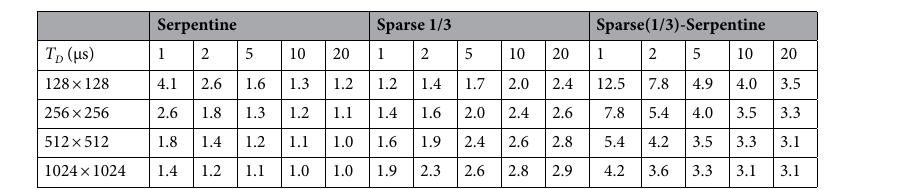
Table 1. Acquisition improvement ratio between the raster and tested custom scanning strategies as a function of pixel-dwell time T D and image size in pixels.